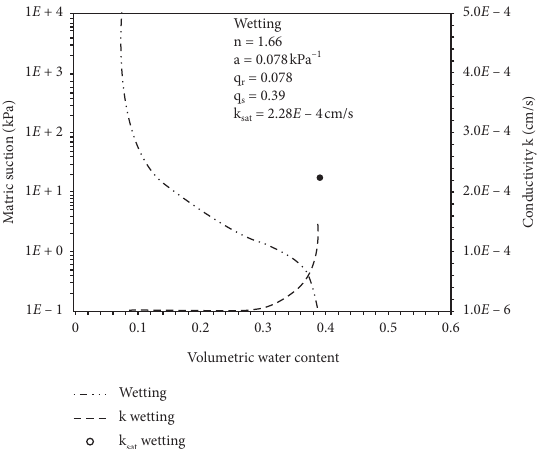
Figure 7: The soil–water curve for moisture absorption and de- humidification and the coefficient of the permeability function curve (HTC).